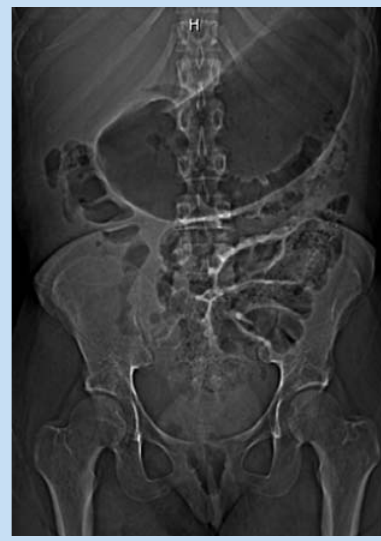
Fig. 1. Supine abdominal radiograph per- formed while in ICU.